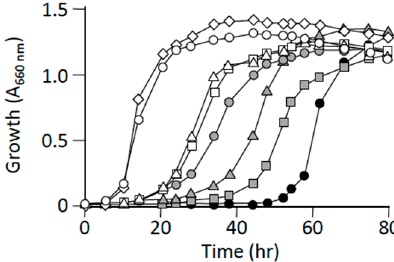
Figure 3. Effect of pyruvate on the growth of L-alanine auxotroph HYE032. HYE032 cells were inoculated into a minimal liquid medium containing various amounts of pyruvate (10–500 µ g/mL), and growth was monitored by measuring the absorbance at 660 nm. Symbols: open diamonds, W3110 with no supplementation; open circles, HYE032 with 100 µ g/mL L-alanine; open triangles, HYE032 with 500 µ g/mL pyruvate; open squares, HYE032 with 300 µ g/mL pyruvate; grey circles, HYE032 with 100 µ g/mL pyruvate; grey triangles, HYE032 with 20 µ g/mL pyruvate; grey squares, HYE032 with 10 µ g/mL pyruvate; closed circles, HYE032 with no supplementation. The figure shows representative results from >2